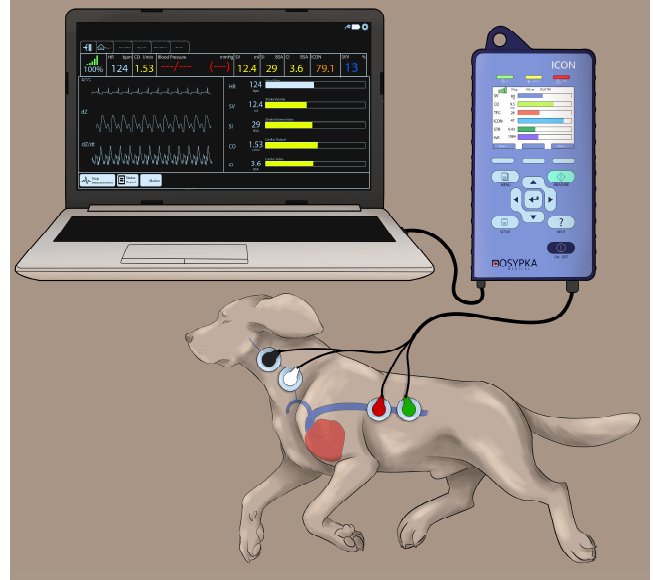
Figure 1. Cardiotronic electrode placement in a Beagle dog placed in the right lateral recumbency while using the electrical cardiometry (EC) monitor (ICON; Osypka Medical Inc., La Jolla, CA, USA). The electrodes are attached to an adhesive patch. The area on the left side of the neck adjacent to the common carotid artery and the left lower aspect of the thorax are clipped, thoroughly cleaned and dried before the application of the adhesive patch. The electrodes are connected to the ICON EC monitor by a cable and the monitor is synced with the laptop using an external communication cable to provide easy data management.